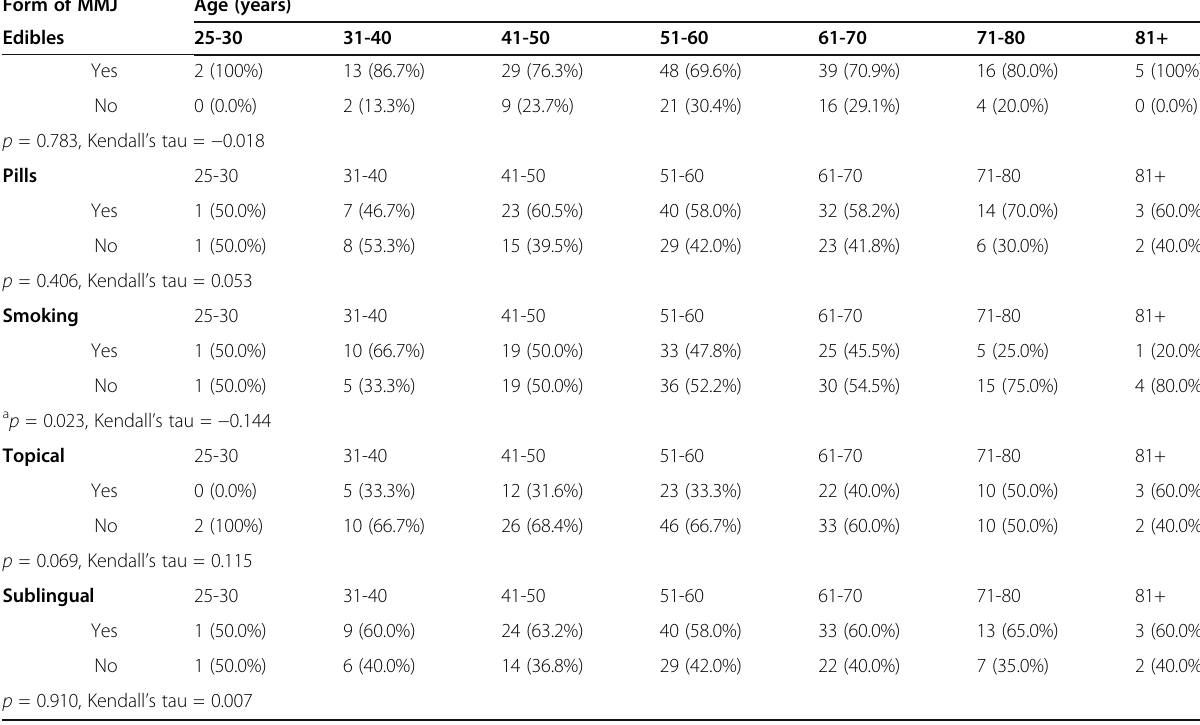
Table 4 Associations between age and preferred forms of medical marijuana ( n = 204) Form of MMJ Age (years) Edibles